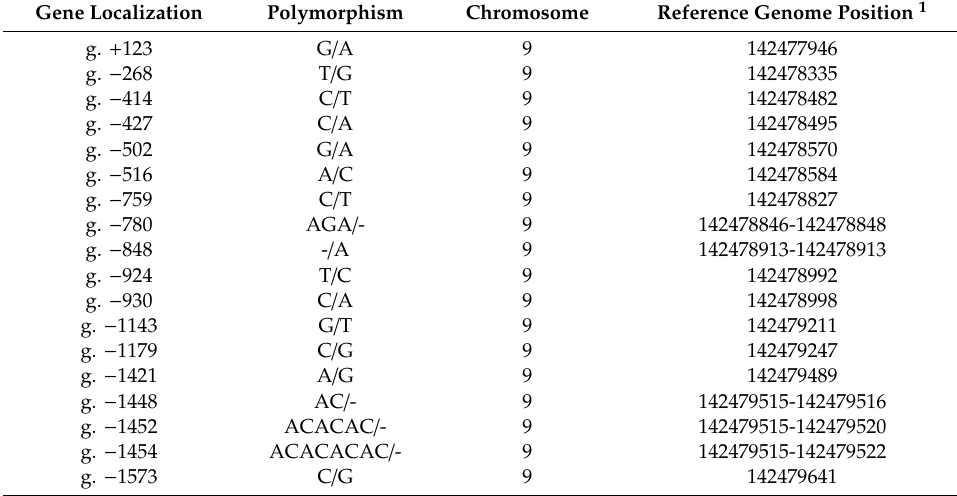
Table 1. Variations identified in the porcine Prox1 promoter 1.